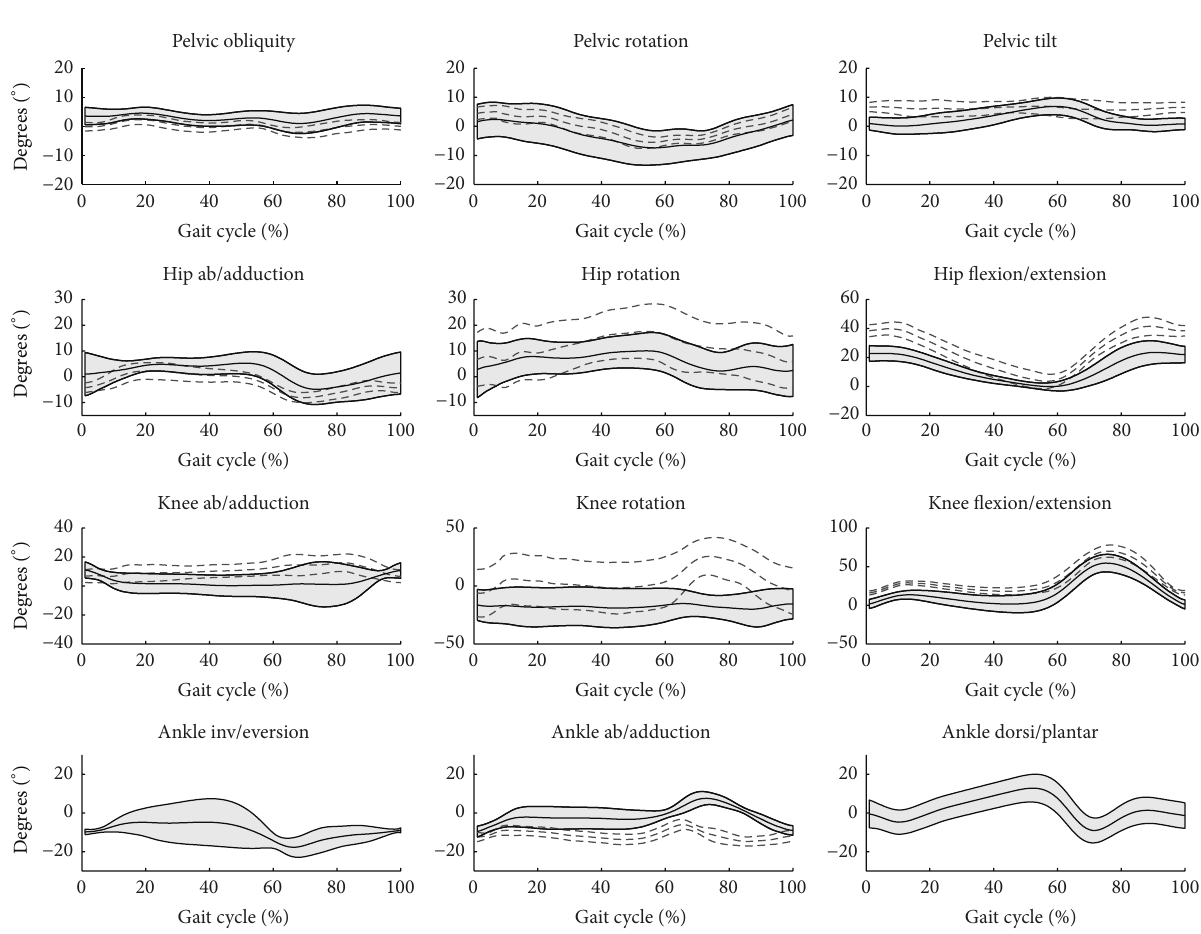
Figure 5: Kinematic variables as calculated by the two protocols, averaged across mean curves of the four subjects. HH—grey dashed line, grey thick line = ± SD, ISB 6DOF—black solid line, grey band = ±